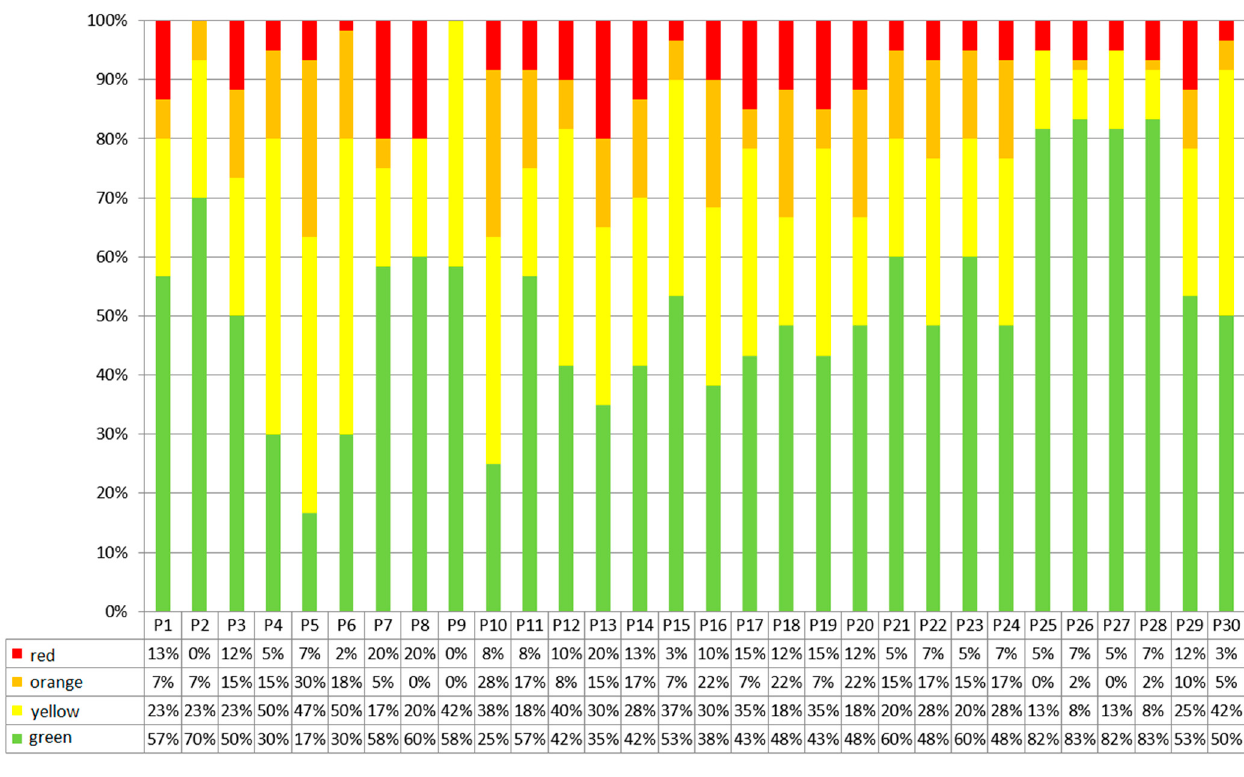
Figure 3. Percentage distribution of results in 4 defined ranges (green, yellow, orange, red) for 30 parameters obtained from patients after stroke—non-dominant upper limb. Table 4. Differences between the selected input parameters in the reference group and the stroke patient